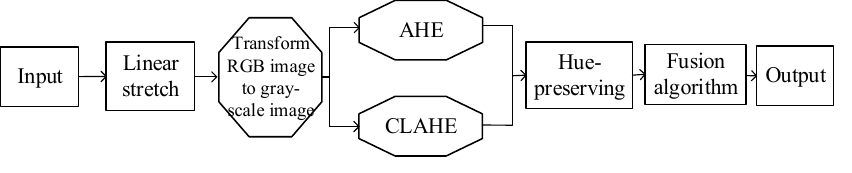
Figure 7. Contrast improvement of underwater images.